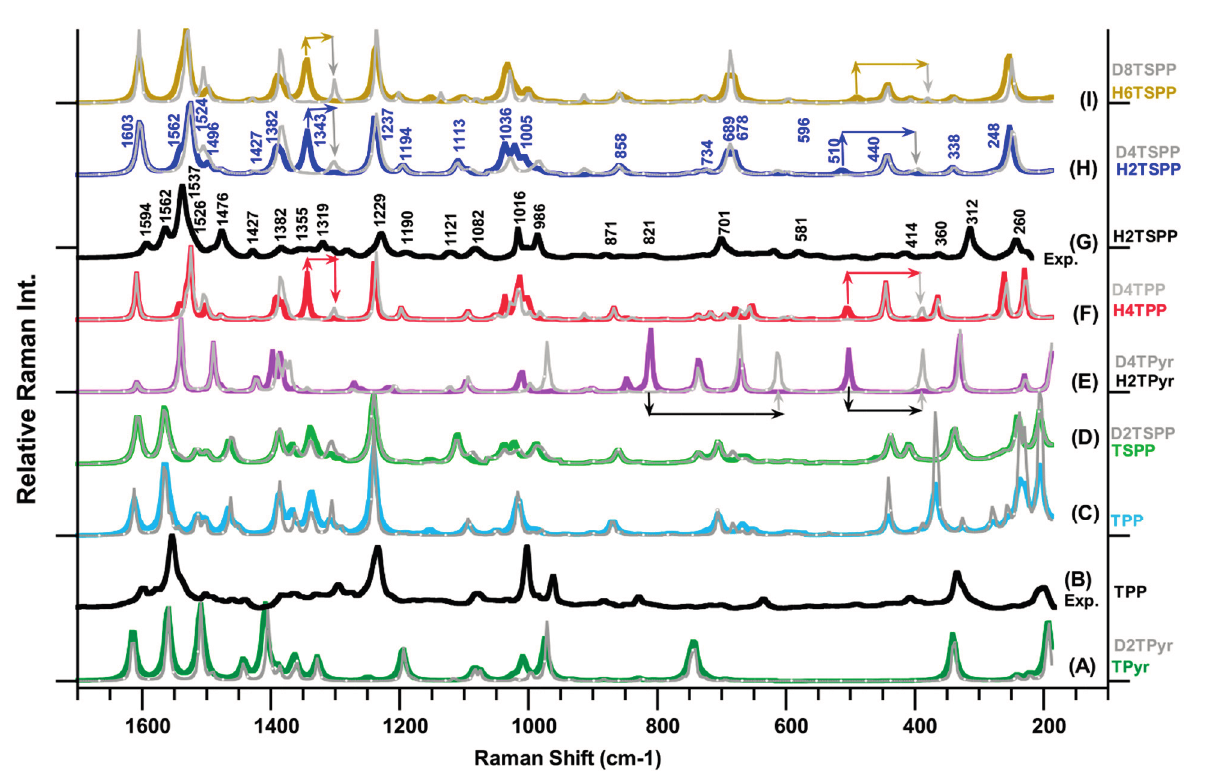
(2) The observed peak at 1563 cm − 1 : while the measured Raman spectrum of the H 2 TSPP